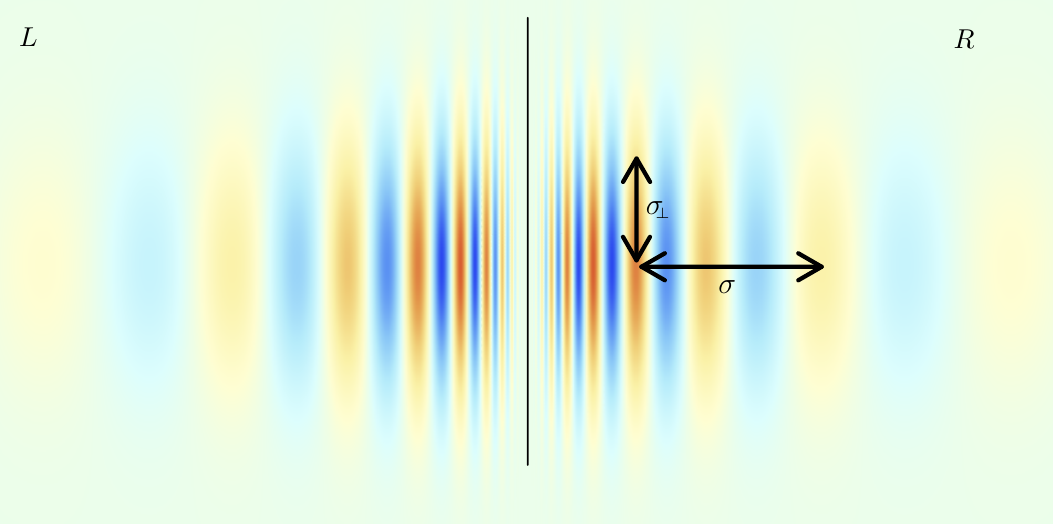
Figure 1 . Real part of a Rindler wavepacket and its ‘mirror’ mode. The parameters are set such that the depiction is most clear, and not to make the wavepackets actually highly